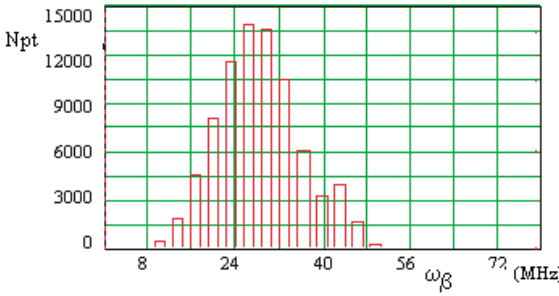
FIG. 7. (Color) The rms envelope oscillation with Gaussian dis- tribution for the case s (cid:5) s 0 (cid:2) 0.83 . The black line represents the odd mode and the magenta line represents the even mode.